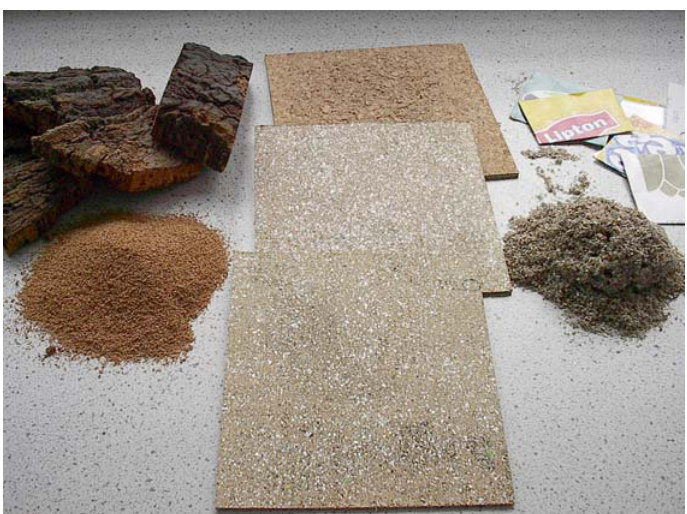
Figure 3. C ork, beverage cartons and composite